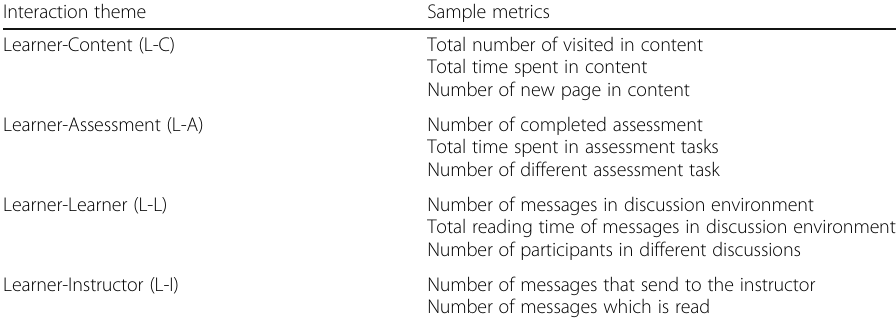
Table 2 Metrics which used in the system as interaction